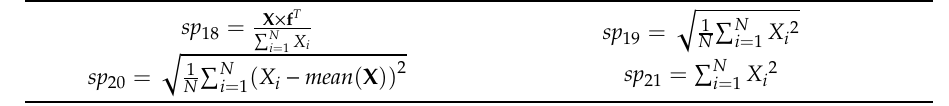
Table 2. General statistical parameters in frequency-space of AE